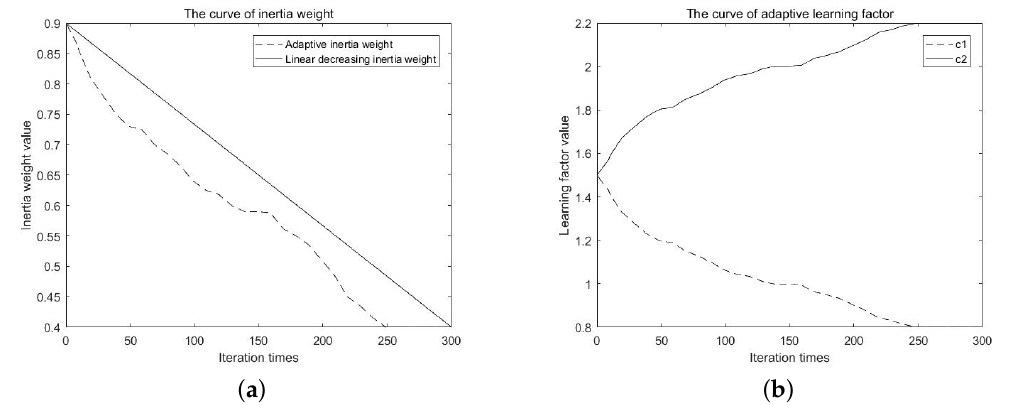
Figure 2. The inertia weight and learning factors as a function of iteration number for ZDT1. ( a ) The curve of adaptive inertia weight and linear decreasing inertia weight; ( b ) The curve of adaptive learning factors c 1 and c 2